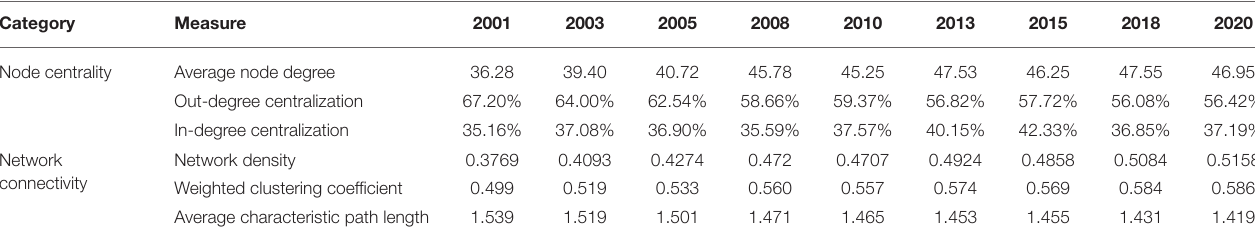
TABLE 1 | Measures of global medical device trade network.